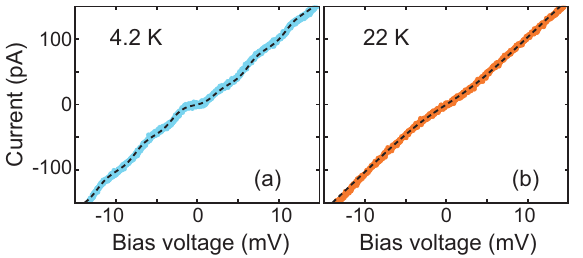
Figure 3. Experimental current − voltage characteristics acquired on device A1, at two different temperatures. ( a ) Data measured at 4.2 K (light blue dots). ( b ) Data acquired at 22 K (orange dots). The black dashed lines indicate the calculated curves using the orthodox Coulomb blockade model with parameters: C 1 = 28 aF, C 2 = 34.7 aF, R 1 = 0.4 M Ω , R 2 = 0.08 G Ω , Q 0 = 0.15 e.